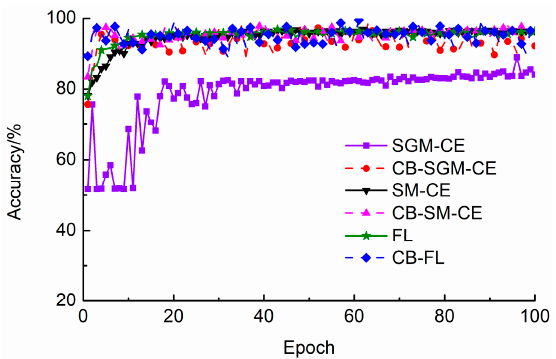
Figure 3. Accuracy curve for validation set using different loss functions.